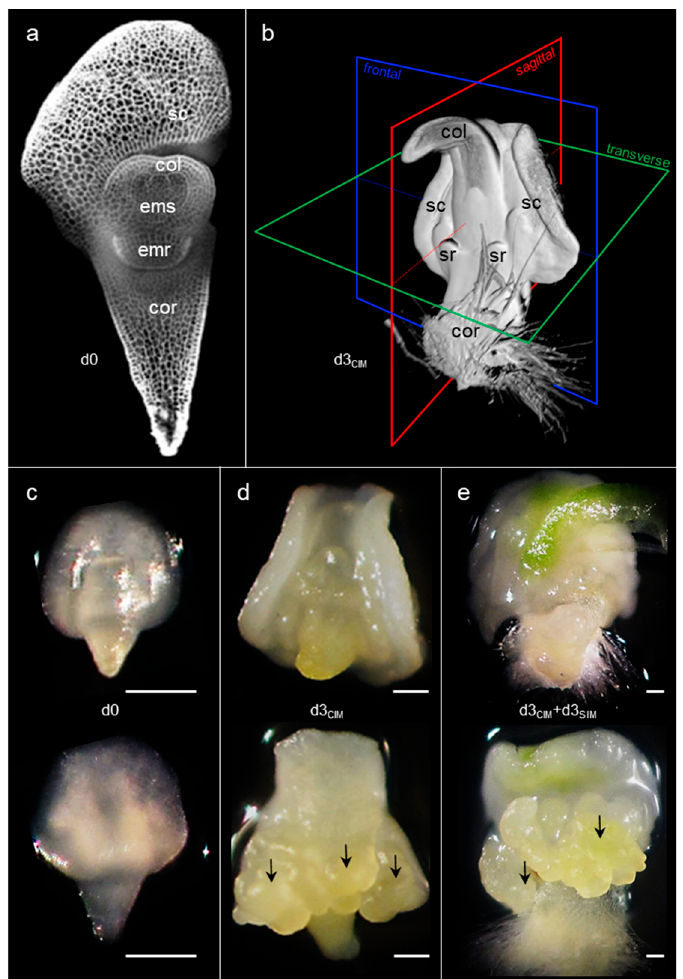
Figure 1. Structure of the Bd izEmb explant. Nine days after pollination (d0), zygotic immature embryos collected for in vitro tissue culture were already well established, as shown in a frontal confocal section of a propidium iodide-stained explant ( a ) or imaged on CIM ( c ). After three days of culture on CIM (d3 CIM ), the scutellum was substantially enlarged and formed two wings that